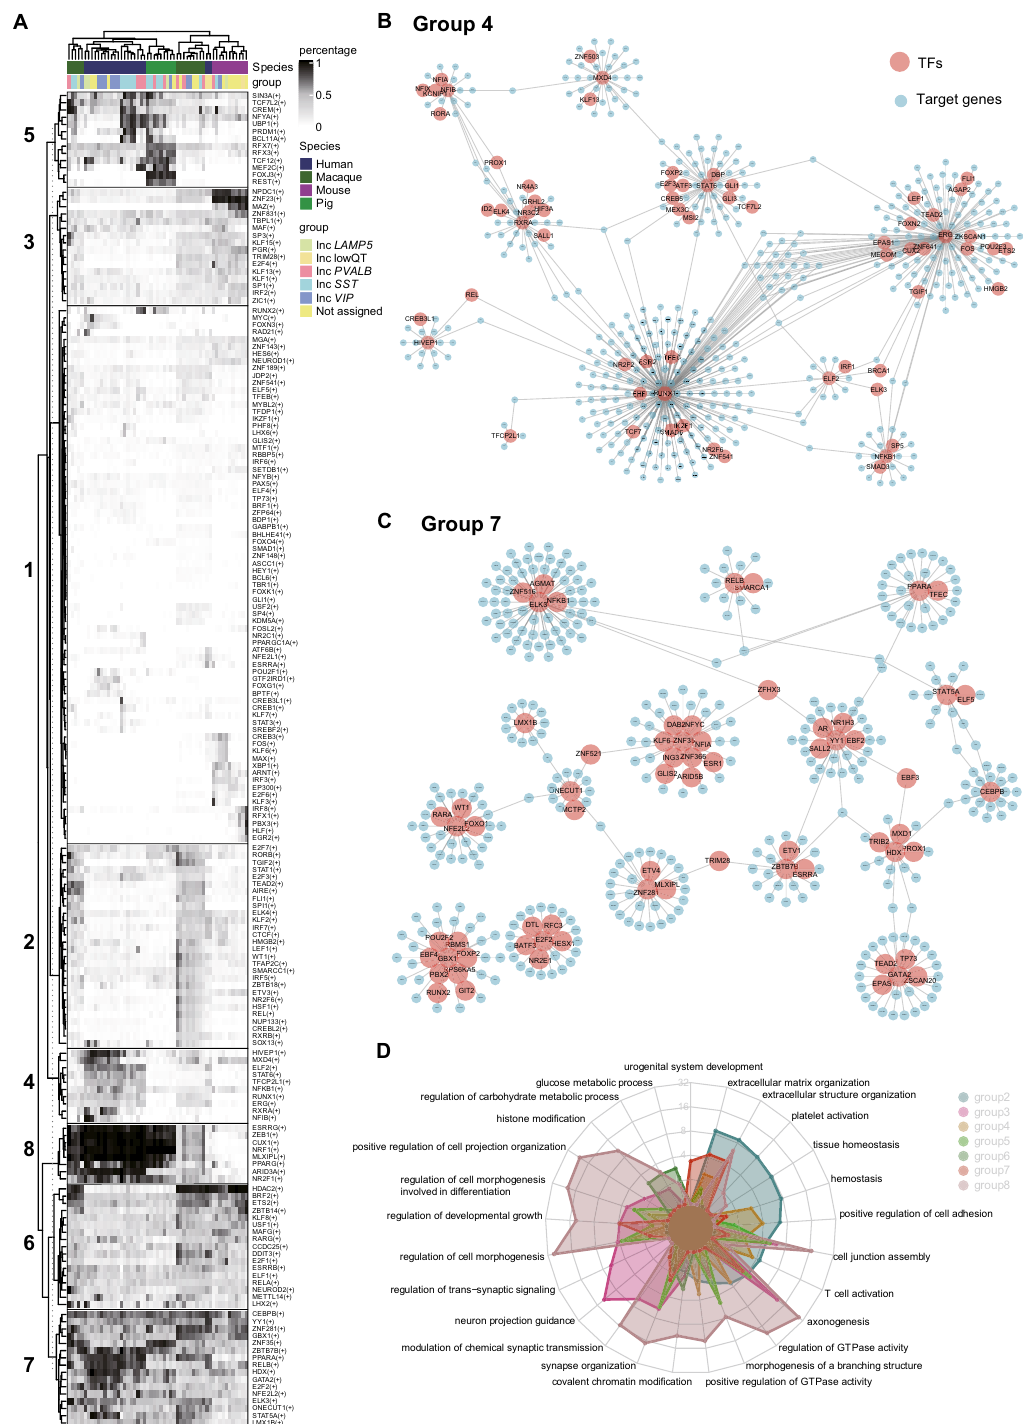
Figure 3. Conserved and specific regulons among four species. ( A ) Heatmap showing the percentage of regulon-activated cells in each subtype in different species. The top annotation indicated species and major cell types. Major regulons were clustered as 8 groups based on activated patterns. ( B , C ) TF-targets regulon networks in groups 4 and 7. Red: TFs; Blue: target genes. ( D ) GO terms enriched from genes of